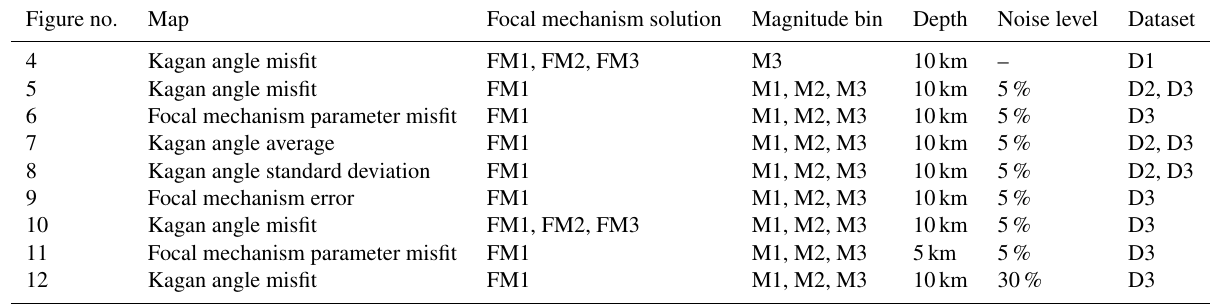
Focal mechanism